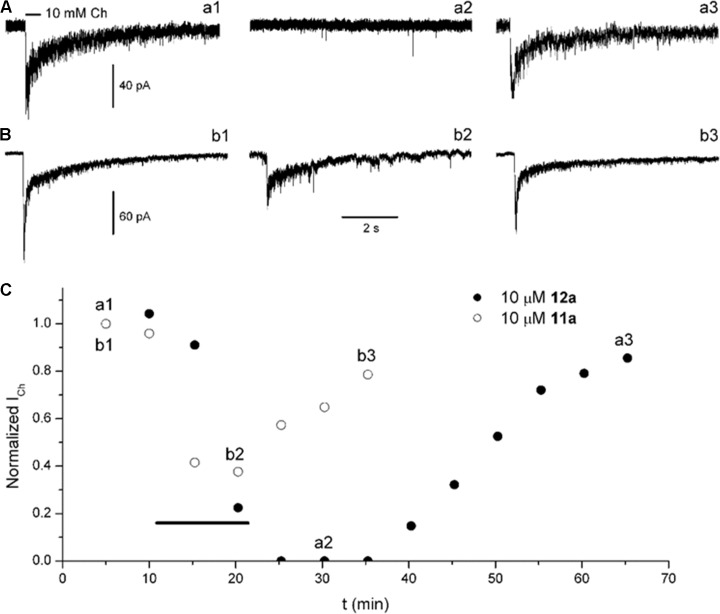
Compounds 12a and 11a inhibited rat hippocampal α7 nAChRs. Ch-puffs were applied at 5-min intervals before, during, and after bath application of the corresponding compound to obtain the ICh amplitude as a function of recording time. (A,B) Representative ICh determinations from seven (12a) and three (11a) separate experiments. Ion currents were elicited by a 5-psi, 500-ms puff of 10 mM Ch (line above the record a1). The horizontal bar calibration applies for all records. (C) The ICh amplitude as a function of time, before, during, and after the application of 12a (filled circles) and 11a (open circles). The timing of the corresponding compound application is indicated by the thick black line.